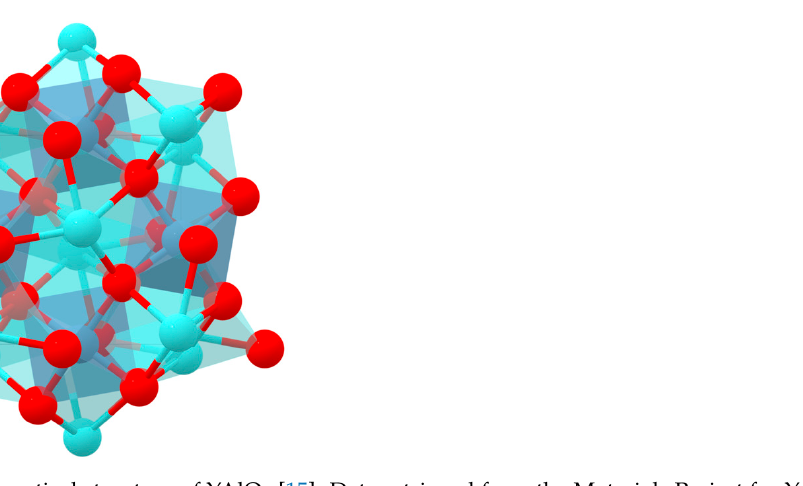
Table 1. Nominal compositions